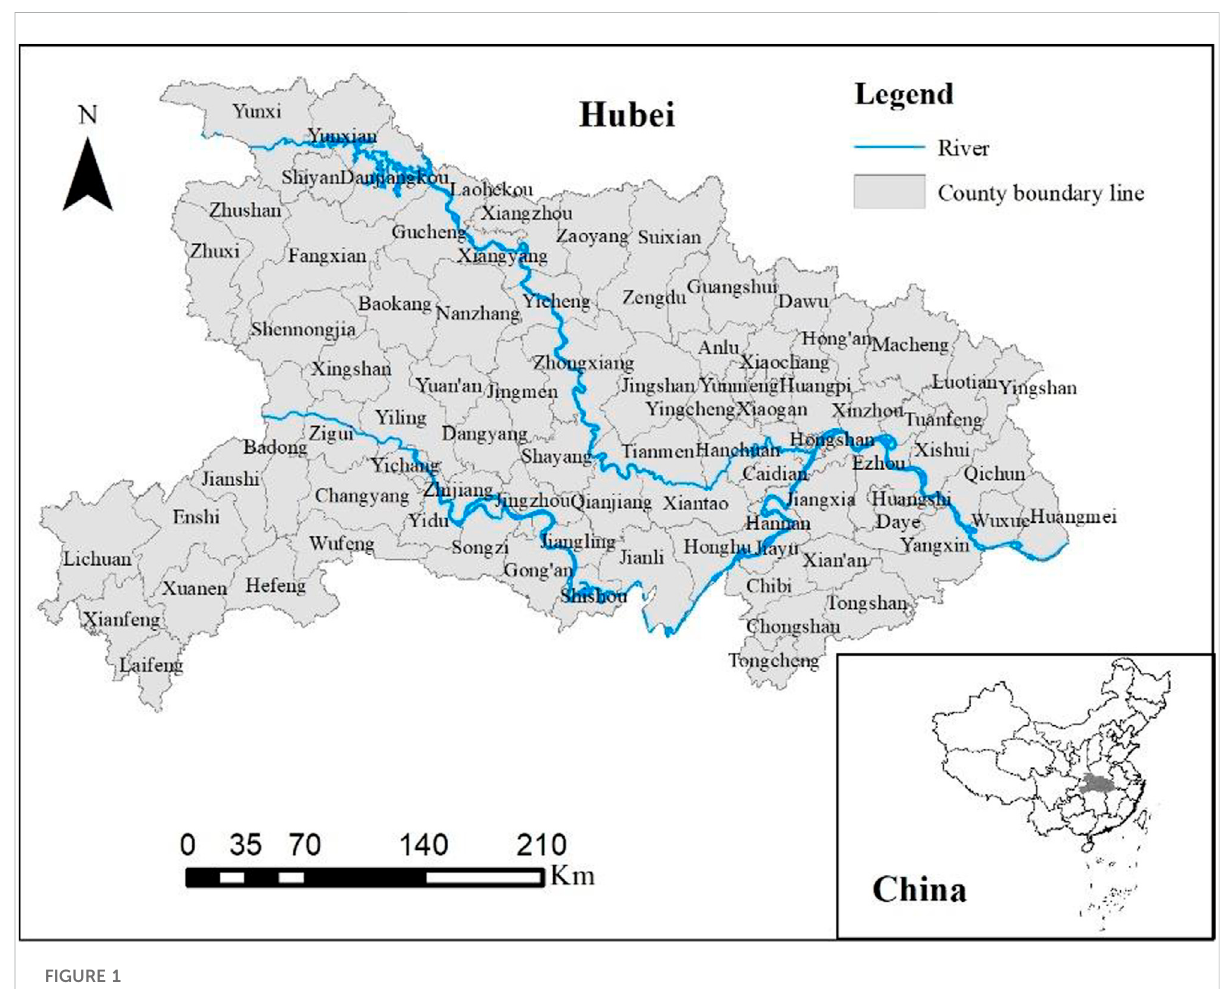
FIGURE 1 Location of the study